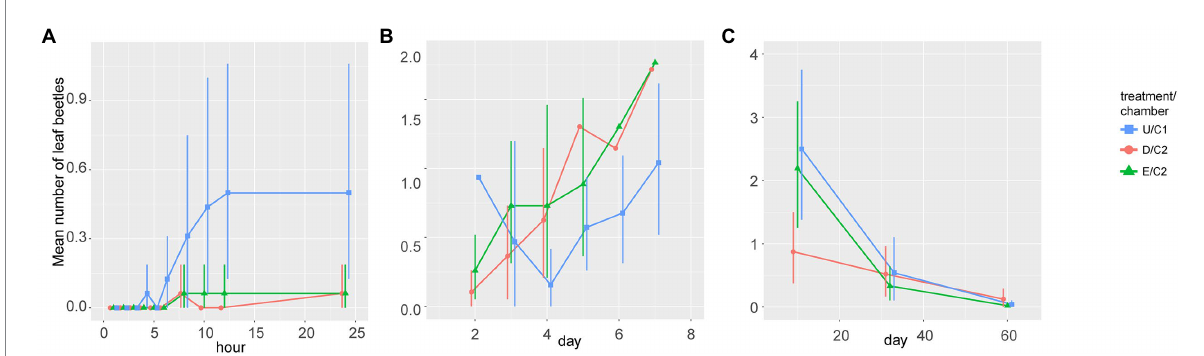
FIGURE 1 Population dynamics of leaf beetles, Plagiodera versicolora . Comparison between the number of adults per plant among undamaged (U), exposed (E), and damaged (D) conditions in phase 1 (A) , phase 2 (B) , and phase 3 (C) . Bars represent 95% confidence